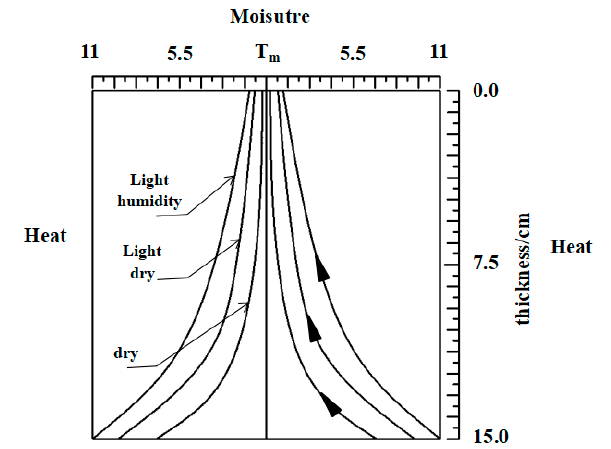
Figure 3. Moisture transfer model of coking coal during drying. According to the moisture transfer model, the coal seam was divided into several areas vertically, from the edge near the heat to the center, which was far away from the heat during drying. Temperature and humidity sensors were used to measure the temperature and moisture change with time in each area. In the experiment, the drying time was set as 360 min, the ambient humidity was 65%, and the oil bath temperature was 130 ◦